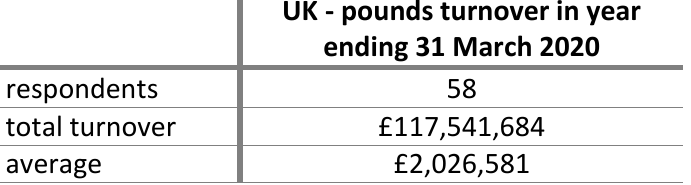
Table 9: Number of respondents to turnover question and combined total turnover in 2020.